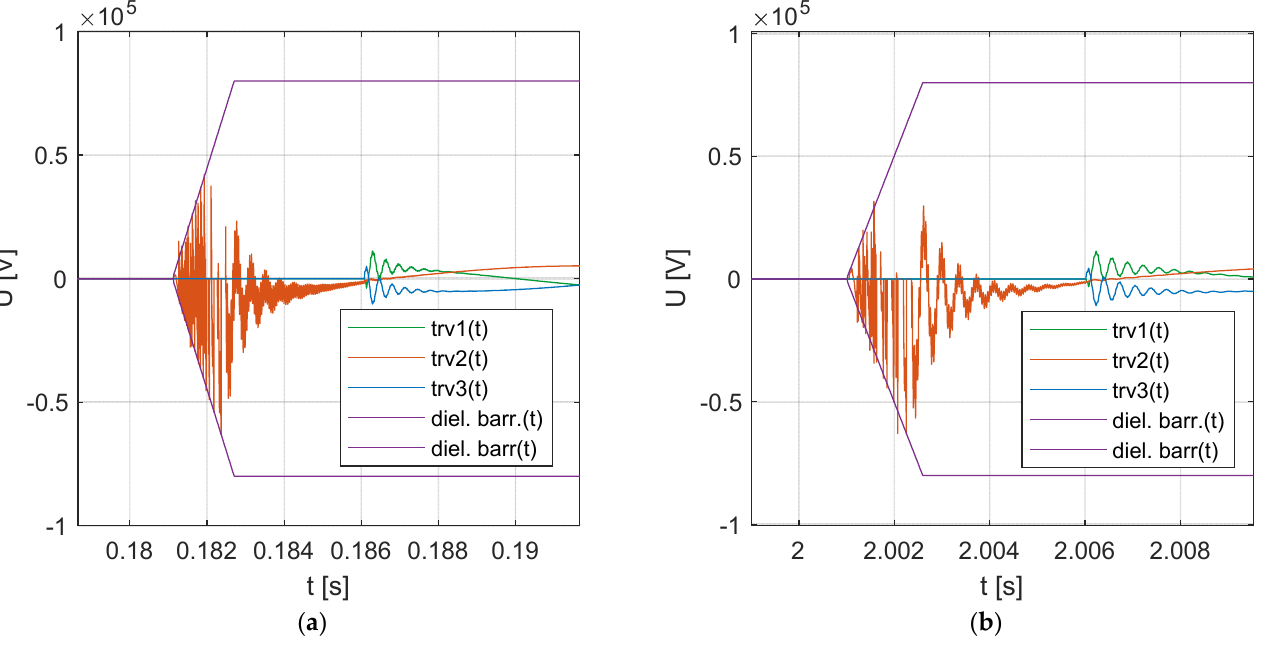
Figure 18. TRV ( a ) EMTP algorithm; ( b ) Clark transformation. Source: own calculations.